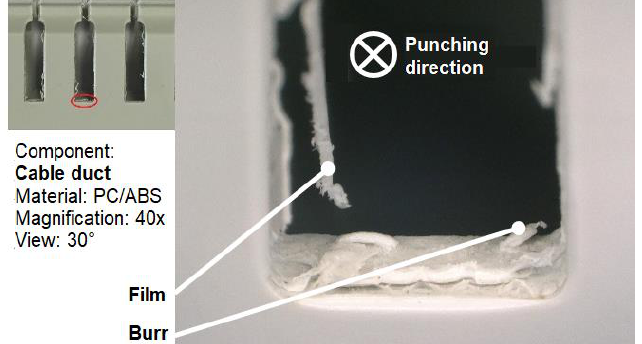
Figure 1. Burr and film formation on a punched-out section of a cable duct made of PC/ABS with an overview on the upper left side and the enlarged area (right) indicated by the red circle [13].